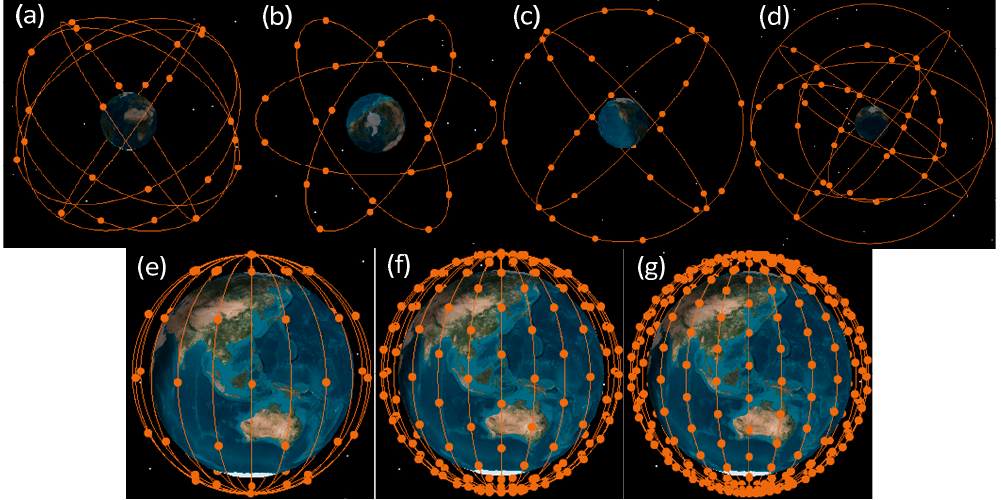
Figure 1. GNSS and designed LEO constellations. ( a ) GPS; ( b ) GLONASS; ( c ) Galileo; ( d ) BDS; ( e ) 60 LEO; ( f ) 192 LEO; ( g ) 288 LEO.